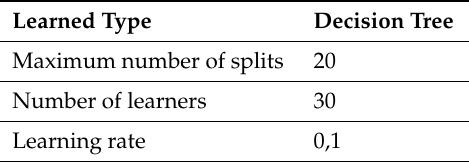
Table 5. RusBoost